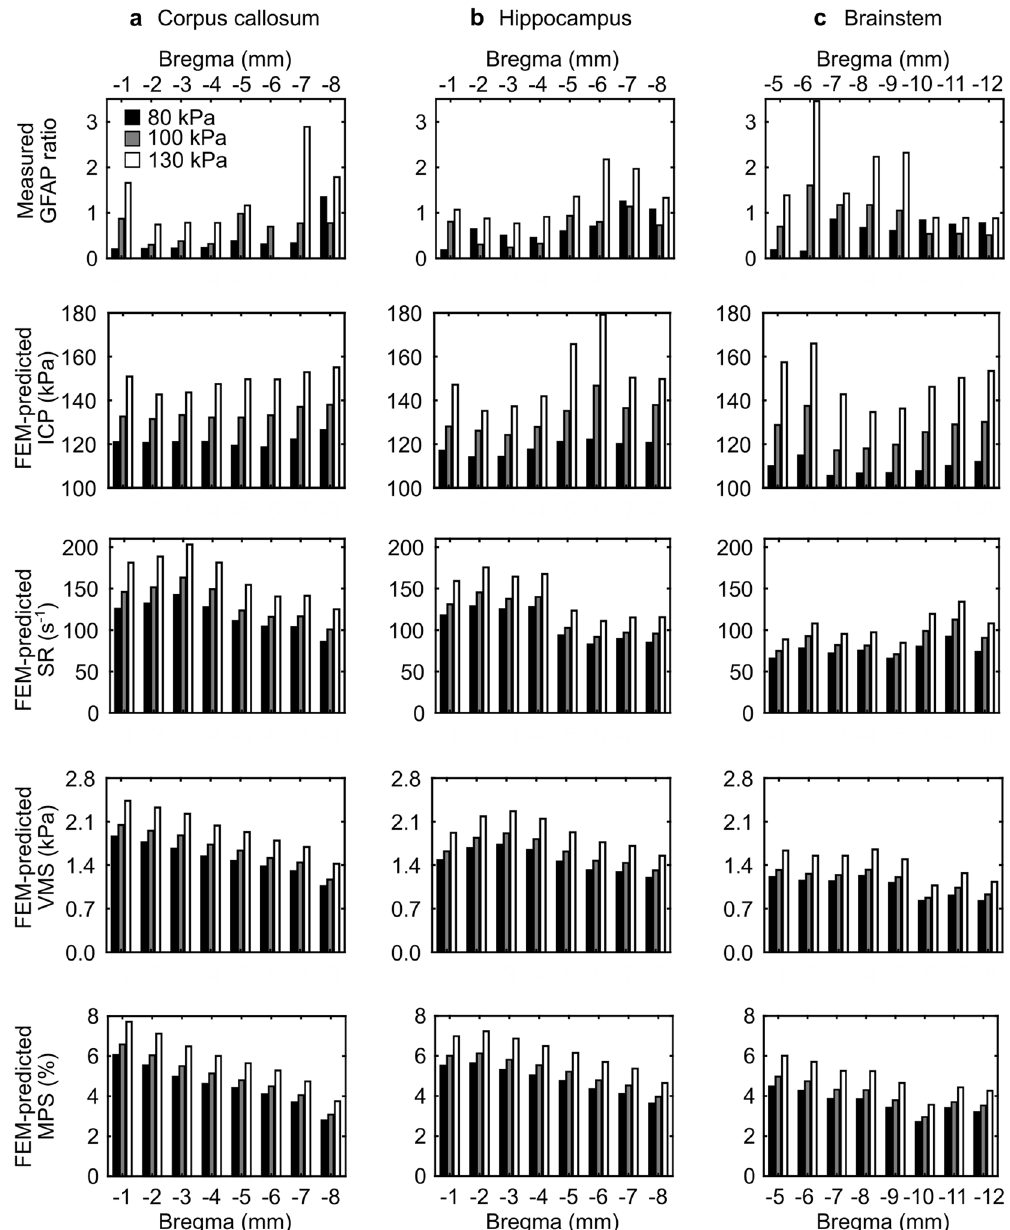
Figure 4. Experimentally measured changes in GFAP and computationally predicted biomechanical responses in the ( a ) corpus callosum, ( b ) hippocampus, and ( c ) brainstem of a rat resulting from a single head-only blast- wave exposure for three blast overpressures. Using the immunohistochemical data for each brain region within a coronal section, we computed a GFAP ratio by dividing the corresponding mean value of the head-only-exposed rats by those of the controls. Using the blast-simulation data for each brain region within a coronal section, we determined the peak 90th percentile of each biomechanical response over the entire simulation time of 5 ms. The corpus callosum and hippocampus spanned from − 1 to − 8 mm relative to Bregma, while the brainstem spanned from − 5 to − 12 mm relative to Bregma. FEM finite-element model, GFAP glial fibrillary acidic protein, ICP intracranial pressure, MPS maximum principal strain, SR strain rate, VMS von Mises